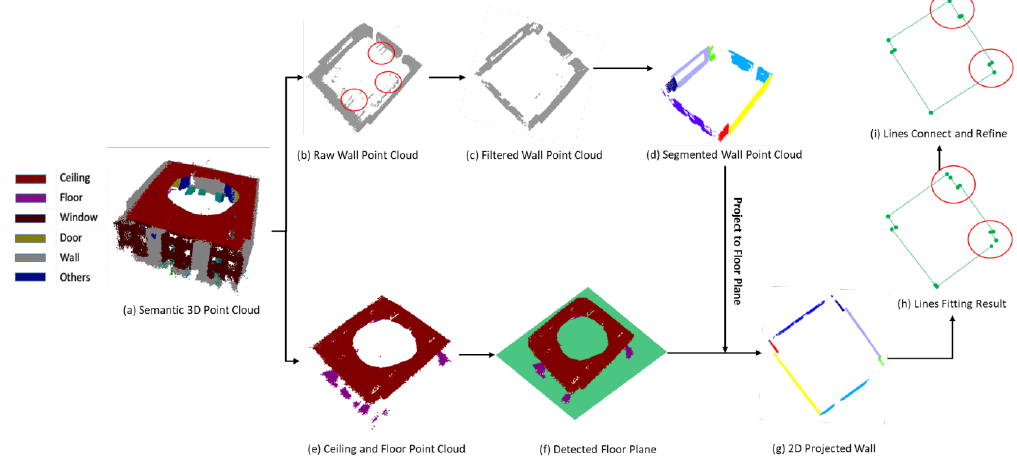
Figure 7. The workflow of wall boundary extraction.